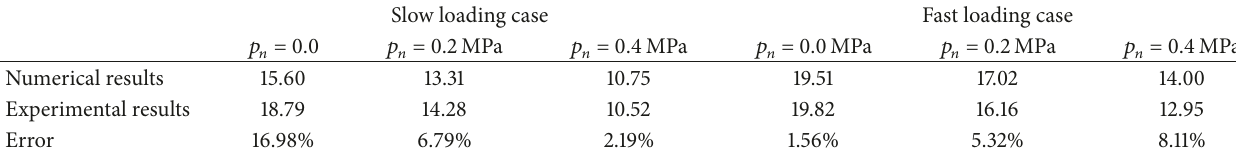
Table 1: The maximum splitting force 𝐹 max / kN.